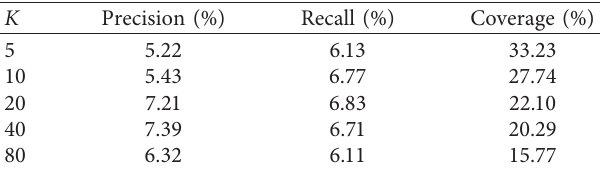
Table 1: User collaborative filtering under different K values based on the Pearson correlation coefficient.